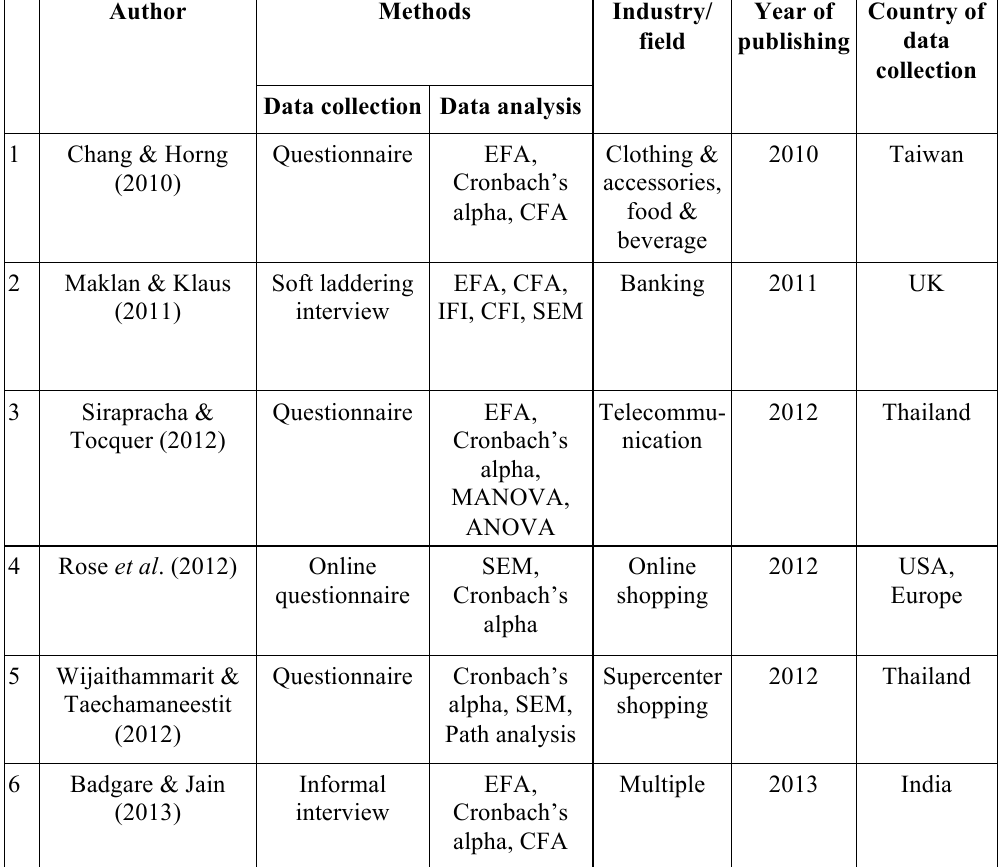
Table 2. Overview of approaches and methods to analyse customer experience with additional